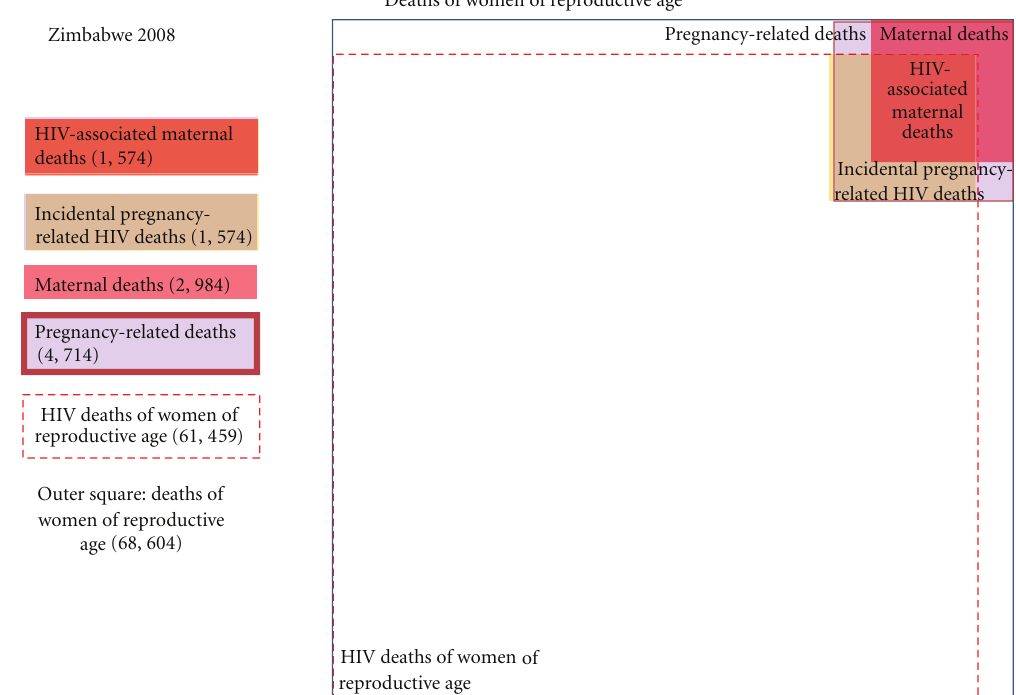
Figure 4: Intersection of HIV and maternal mortality in Zimbabwe, 2008. Source: http://www.who.int/gho/maternal health/mortality/